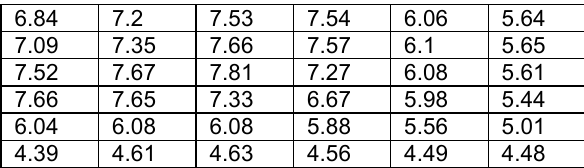
Table 1. Entropy of FRFT results in gingivitis images